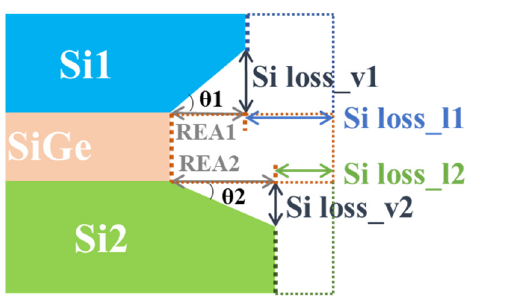
Figure 5. The structural diagram of the etching morphology. The dashed lines represent the initial envelope lines of the fresh sample. The solid boxes are the envelope lines as they were etched.